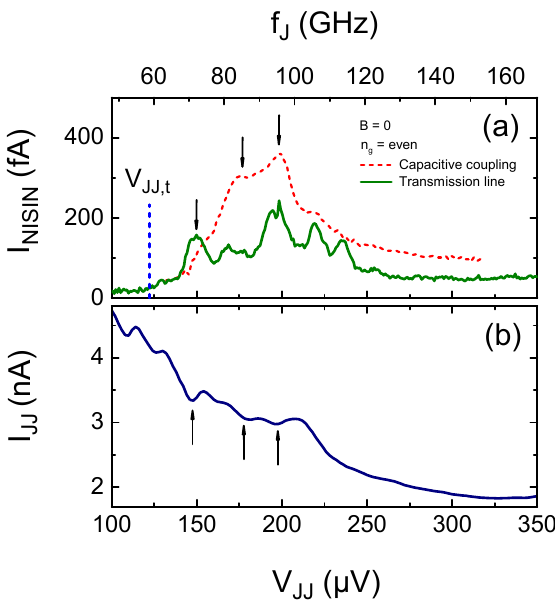
Figure 6. ( a ) The detector response as a function of the frequency of the microwave irradiation generated at V JJ < V max . The signal delivered over the transmission line (green curve) is compared to that over the capacitive coupling (red dashed curve). The stronger response in the sample with the capacitive coupling appears due to the larger value of critical current, I C ∼ 48nA, than in that with the transmission line, I C ∼ 32nA; ( b ) An I - V curve measured in the same voltage range for one of the Josephson sources. Those peculiarities which coincide with observed peaks in the detector responses are marked by black